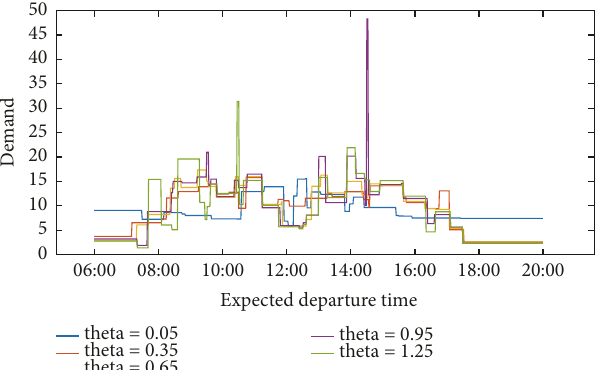
Figure 9: The time-varying demand distribution from SBPRA algorithm with different parameter 𝜃